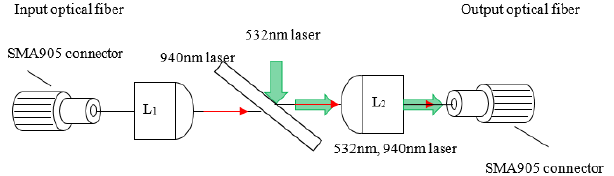
Fig. 4. Diagram of the beam combination device.